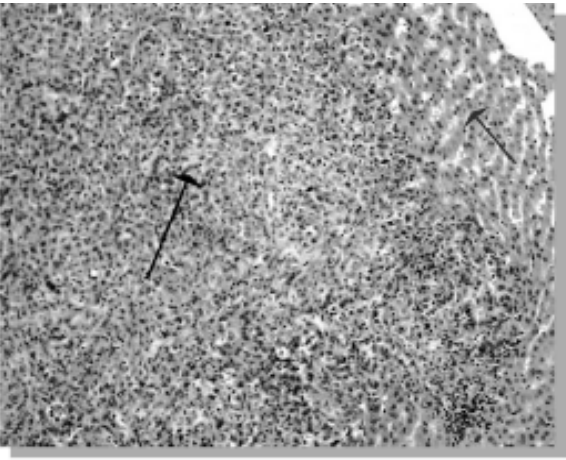
Figura 2 – Corte histológico do fígado de coelho portador do tumor VX-2, decorridos 7 dias da infiltração de suspensão de células tumorais. Notar o extenso nódulo tumoral (seta preta) com parênquima hepático normal adjacente (seta azul). X200. Coloração